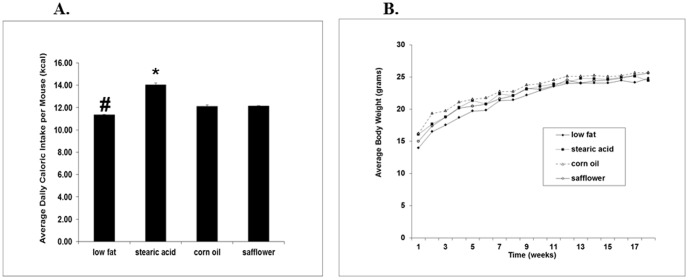
Average daily caloric intake and average weekly body weights.There were 10 mice in each diet group. (A) *, stearic acid vs. all other diets, p<0.01. #, low fat vs. all other diet groups, p<0.007. (B) There were no significant changes in body weight among the four experimental groups throughout the study. The average initial body weight was 15.3±2.6 g (p = 0.277) and the final body weight was 25.0±2.3 g (p = 0.203).